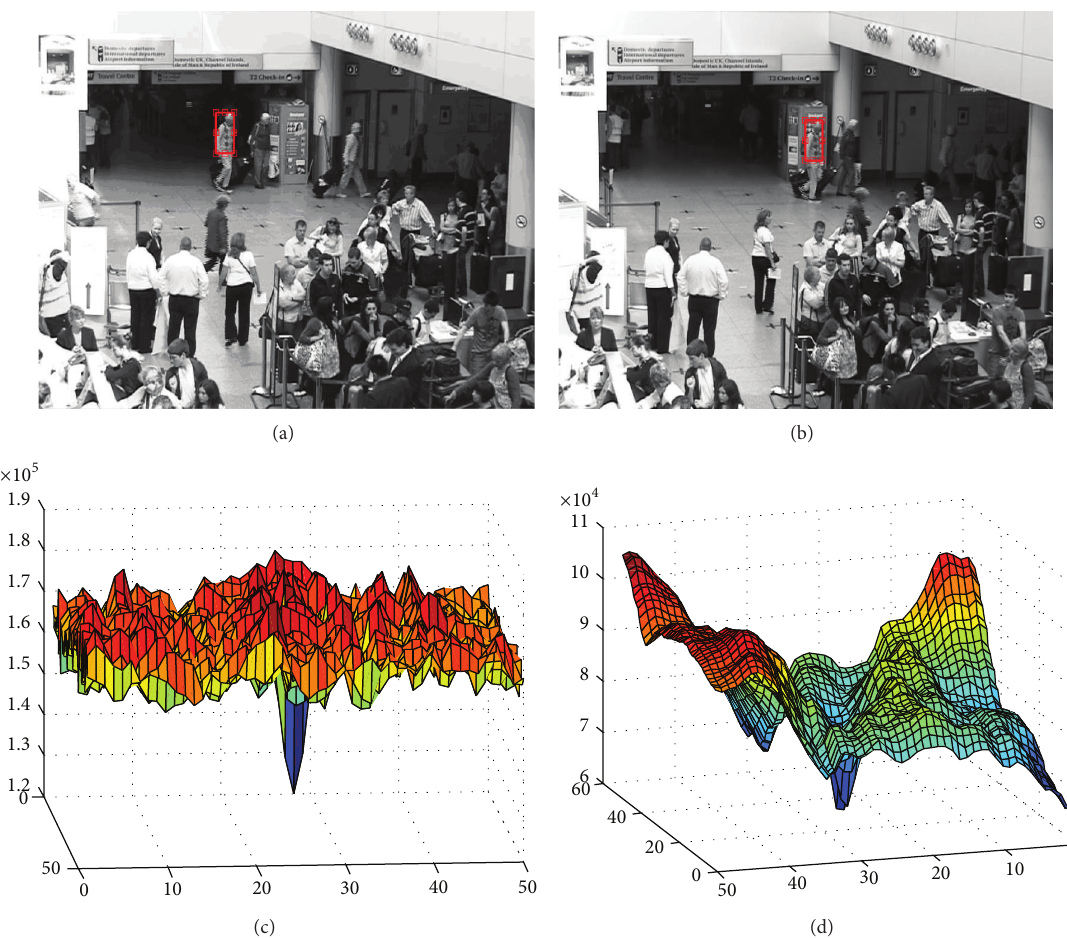
Figure 2: Different features show different discriminative abilities. (a) The target window within a red bounding box in reference image. (b) Current target window after object moving. (c) Image error between reference image and candidate image around current target window with edge cue. (d) Image error between reference image and candidate image around current target window with